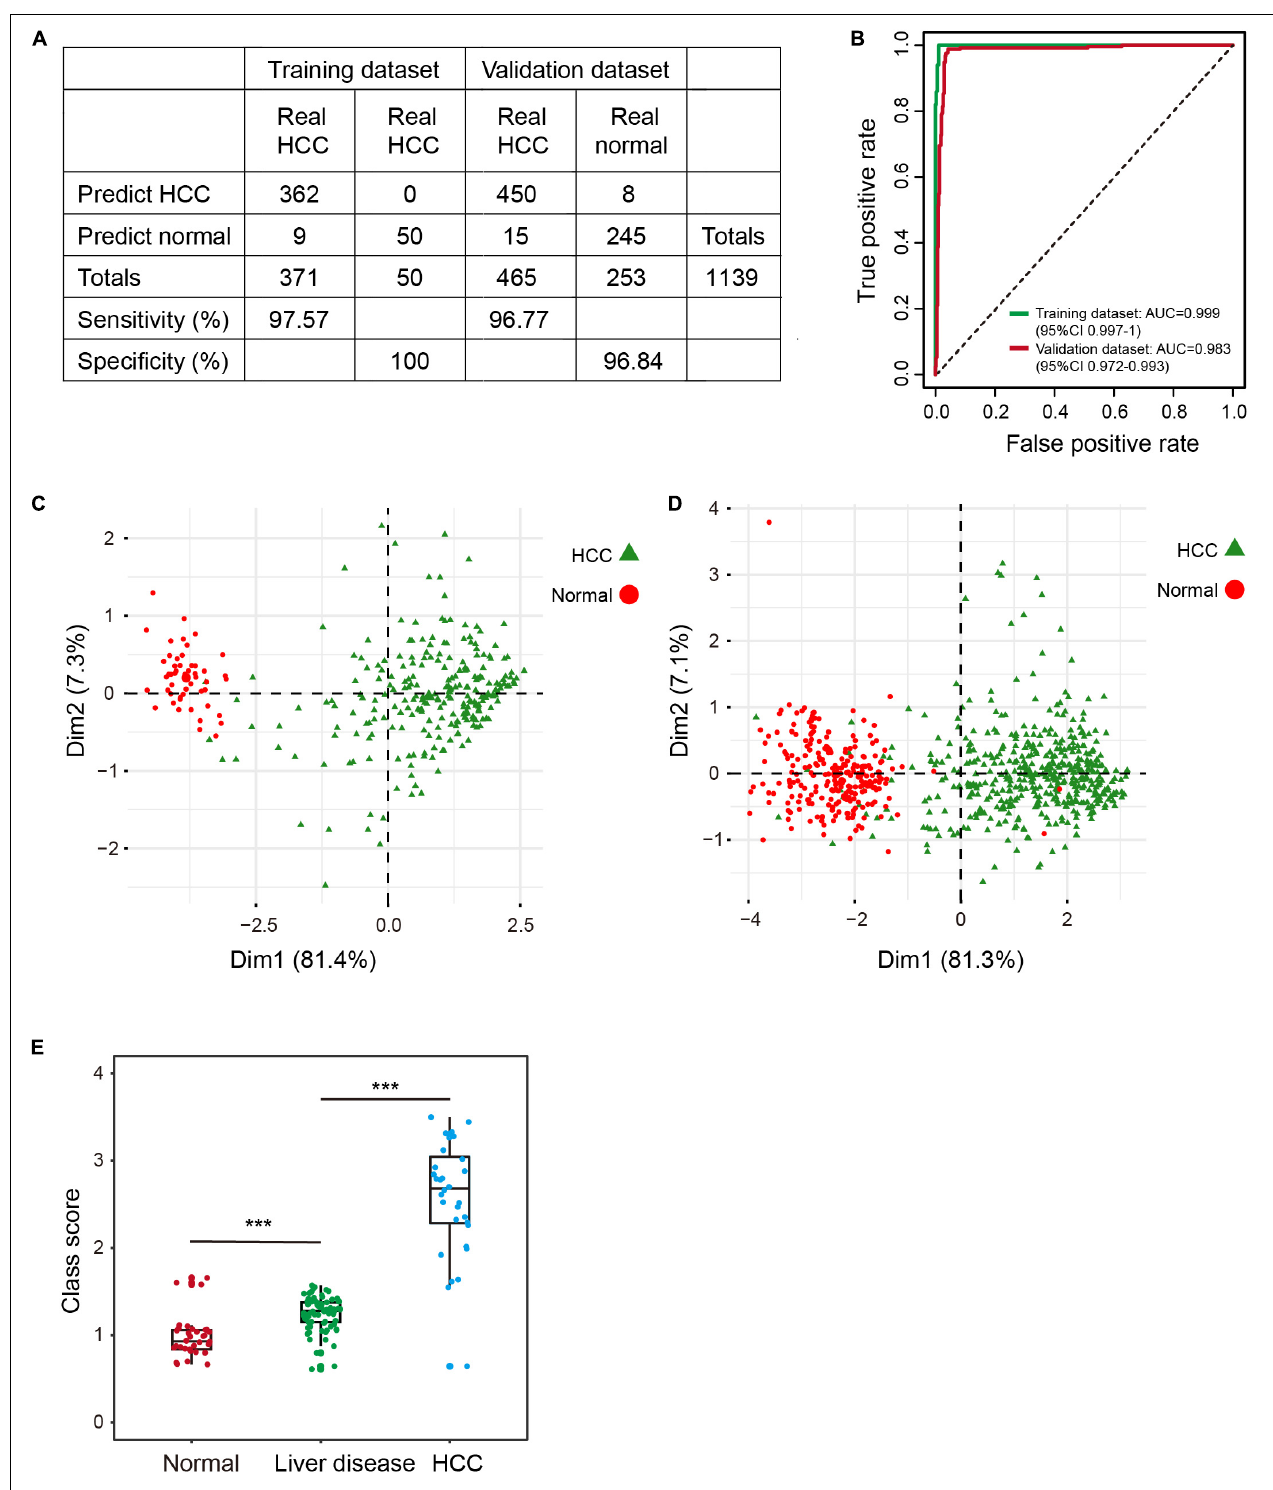
FIGURE 2 | Evaluation of the diagnostic signature in the training (TCGA) and validation datasets (GSE54503, GSE56588, GSE60753, GSE75041, GSE77269, and GSE89852). (A) The predicted results of the diagnostic signature in the training and validation datasets. (B) ROC curves of the diagnostic signature in the training and validation datasets. (C,D) PCA analysis of the five DNA methylation markers between HCC patients (green) and normal controls (red) in the training (C) and validation (D) datasets. *** p < 0.001 from Wilcoxon test. (E) Distribution of class-scores for the diagnostic signature of normal controls, individuals with liver diseases (alcoholism and HBV/HCV cirrhosis), and HCC patients in GSE60753 dataset.